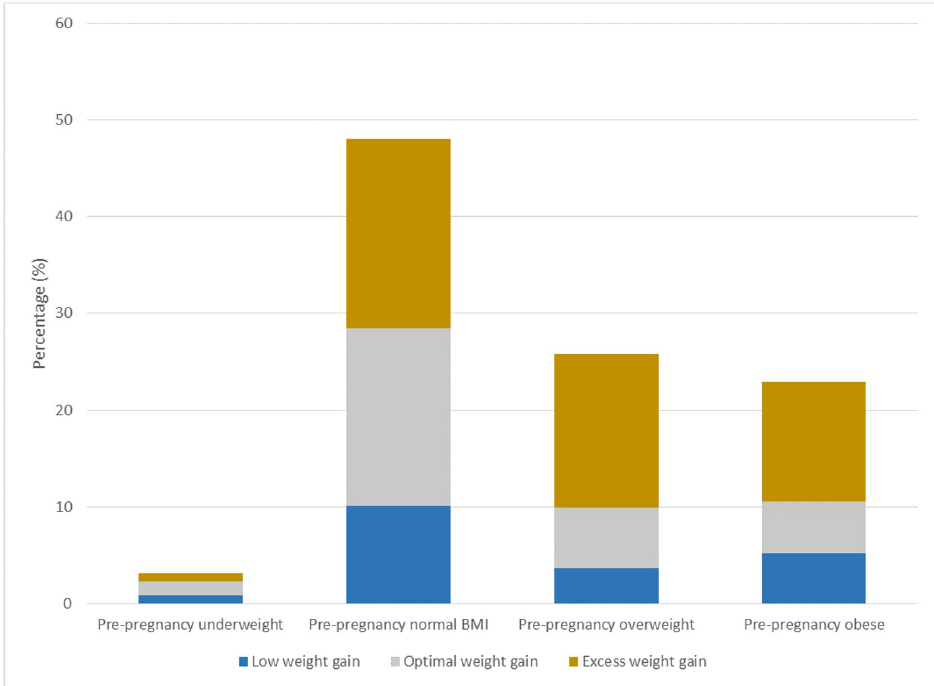
Fig 1. Pre-pregnancy BMI category and gestational weight gain for singleton births, Washington State, 2004– 2013.